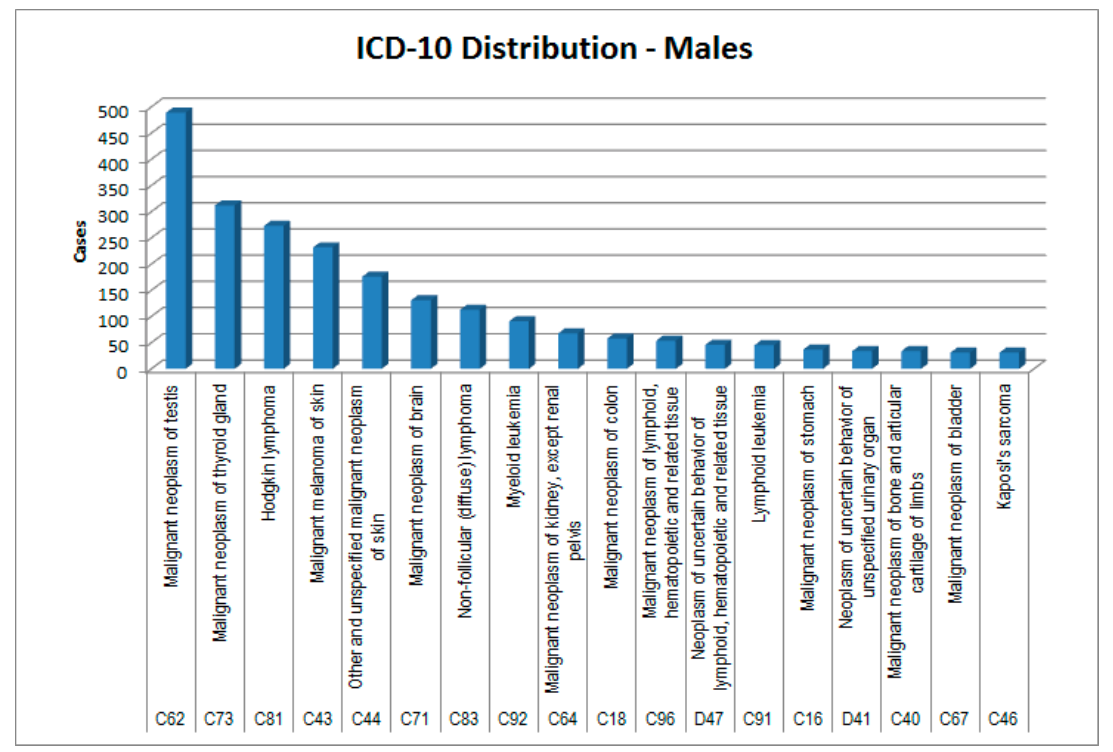
Figure 4. ICD ‐ 10 distribution of cases—males.